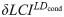
Linear sensitivity (computed for model P) of LCI and to changes in three global model parameters vs. baseline constriction magnitude (of central airways in RM lobe).In the notation of Eq (6) the plot shows δLCILDcond (length-diameter ratio, black solid line), δLCIVD (airway dead-space, red dash-dotted line), and δLCIKlung (lung elastance, blue dotted line). Each point corresponds to a single simulation of model M with localised constrictions (where the baseline LCI values are given by Fig 4(a)).